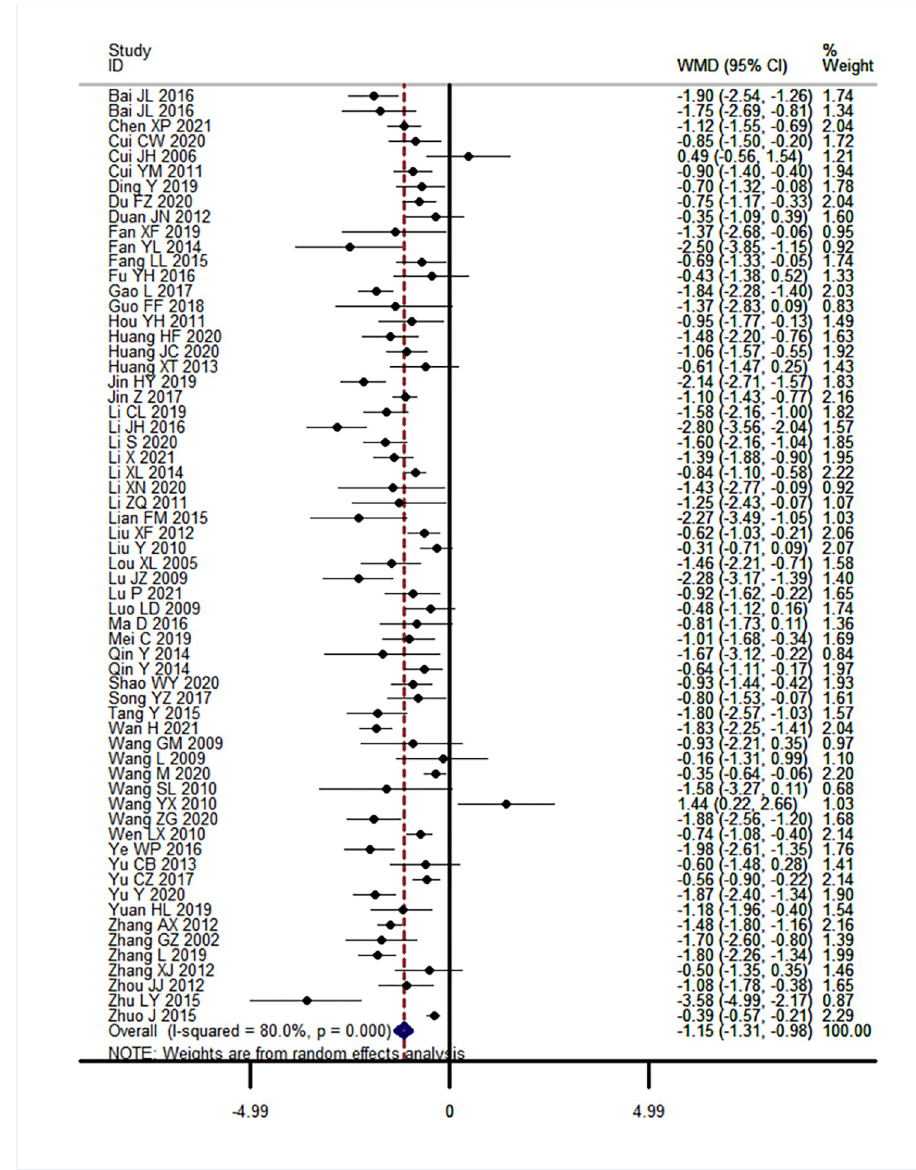
Fig 3. Forest plot of 2-hour postprandial blood glucose level at end of treatment, Fuling formulae plus hypoglycaemic agents versus hypoglycaemic agents alone, results of meta-analysis. significant differences between groups (Table 3). Subgroup analyses based on TCM syndrome differentiation showed favourable results in T2DM participants with qi and yin deficiency, phlegm-dampness and blood stasis, and Spleen deficiency. In six studies that included over- weight people with diabetes, results showed improvement in HbA values at the end of the 1c treatment with low heterogeneity (n = 418; -0.39 [-0.57, -0.22], I 2 = 32.8%, P = 0.00). 3.3.2. Blood lipid metabolism indicators. 3 . 3 . 2 . 1 . Total cholesterol (TG) . Thirty RCTs including 2,571 participants assessed the effects of CHM plus hypoglycaemic agents versus hypoglycaemic agents alone [21, 22, 25, 26, 28–30, 32, 34, 36, 38, 42, 43, 46–48, 51, 53, 59, 65– 68, 74–76, 78, 80, 83, 90]. All studies used the same hypoglycaemic agents in both groups,